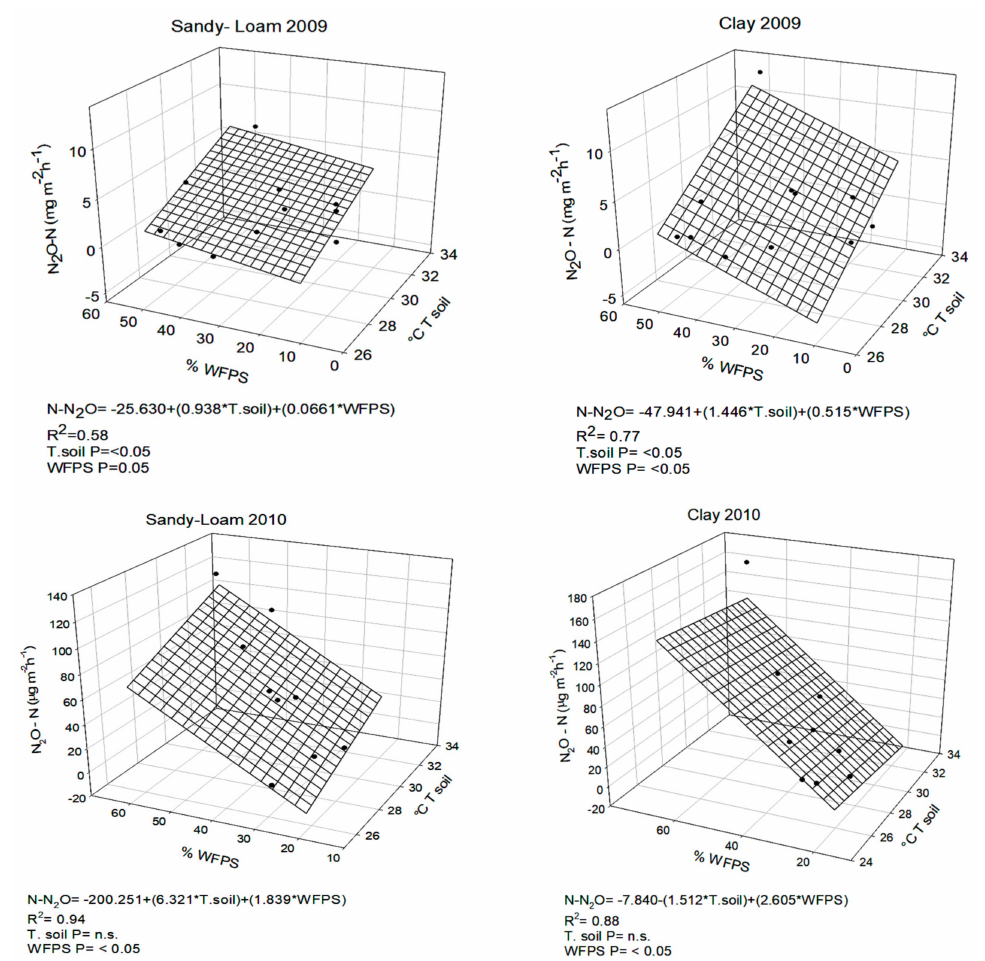
Figure 3. MultiplelinearregressionfortherelationshipbetweenN 2